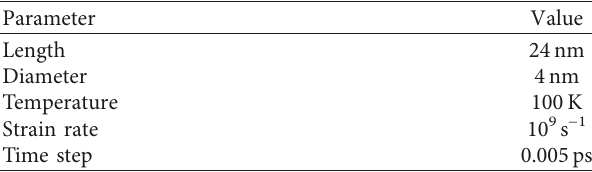
Table 1: Simulation parameters for Au nanowire